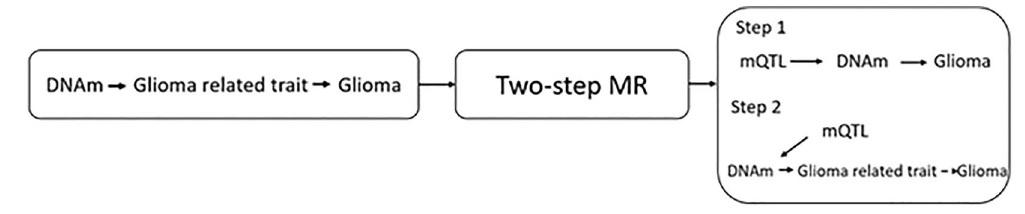
Figure 6. A summary of hypothesis 1. Does DNA methylation (DNAm) mediate the effect of the glioma related trait on glioma risk? MR, Mendelian randomization; mQTL, methylation quantitative trait loci.